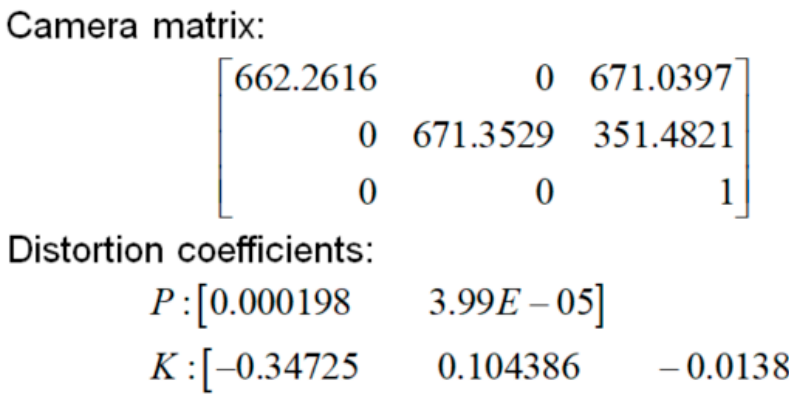
Figure 4. Internal camera parameter matrix.